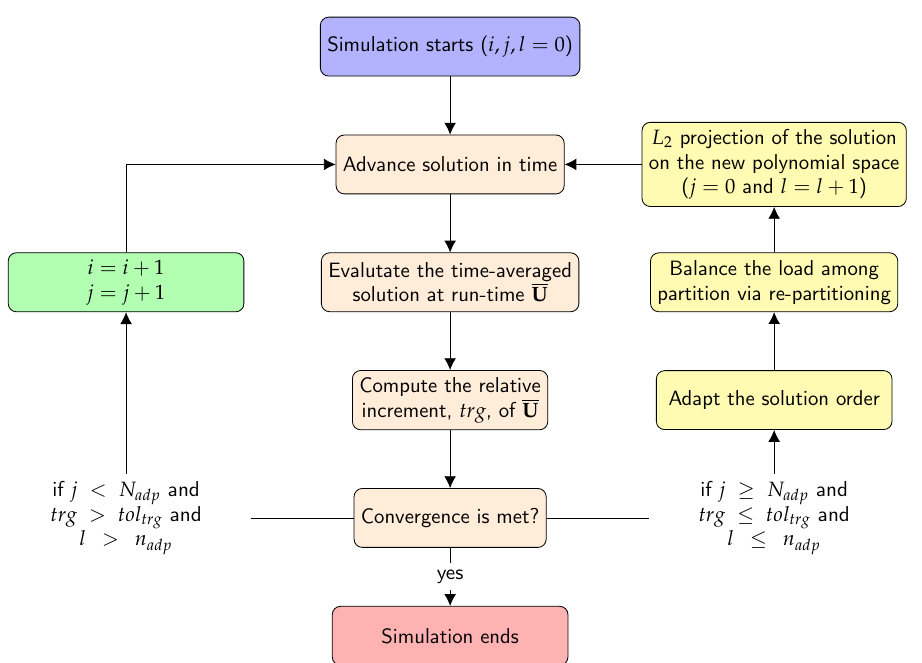
Figure 2. Flowchart of the p -adaptation strategy.